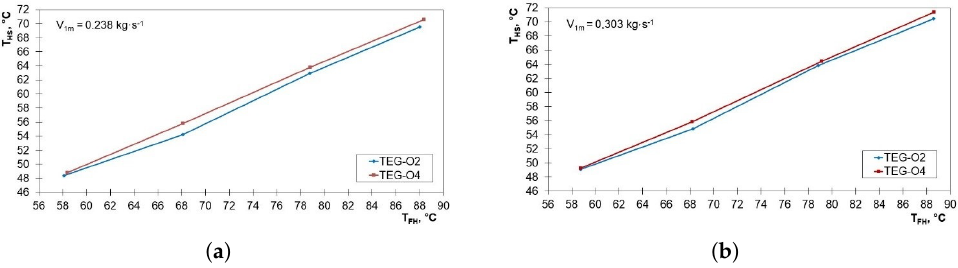
Figure 10. Characteristics of the dependence of inlet and outlet temperatures for extreme effectiveness cases at different flows: ( a ) V 1 m = 0.238 kg · s − 1 ; ( b ) V 1 m = 0.303 kg · s − 1 .